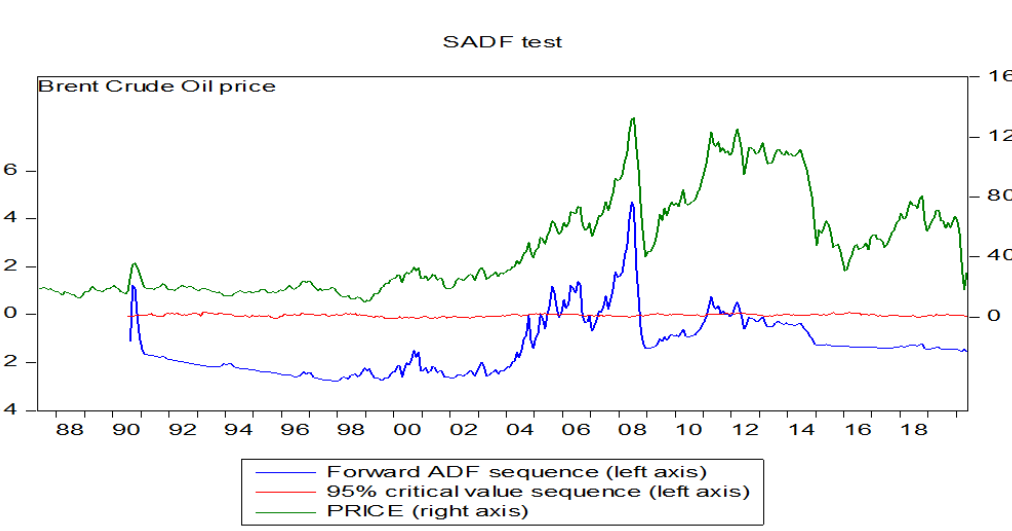
Figure 4. SADF output for Brent crude oil price.